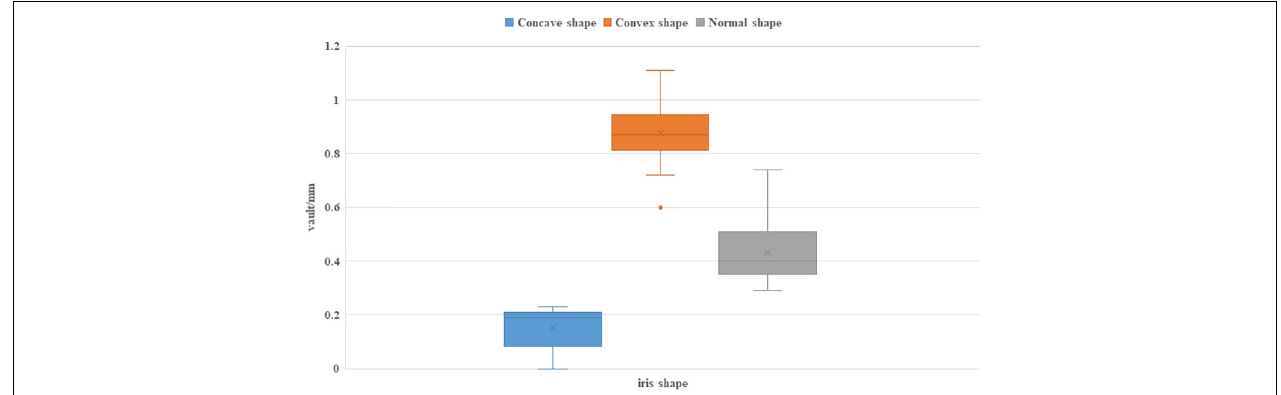
FIGURE 3 | The vault distribution after ICL implantation of eyes with different iris shape.